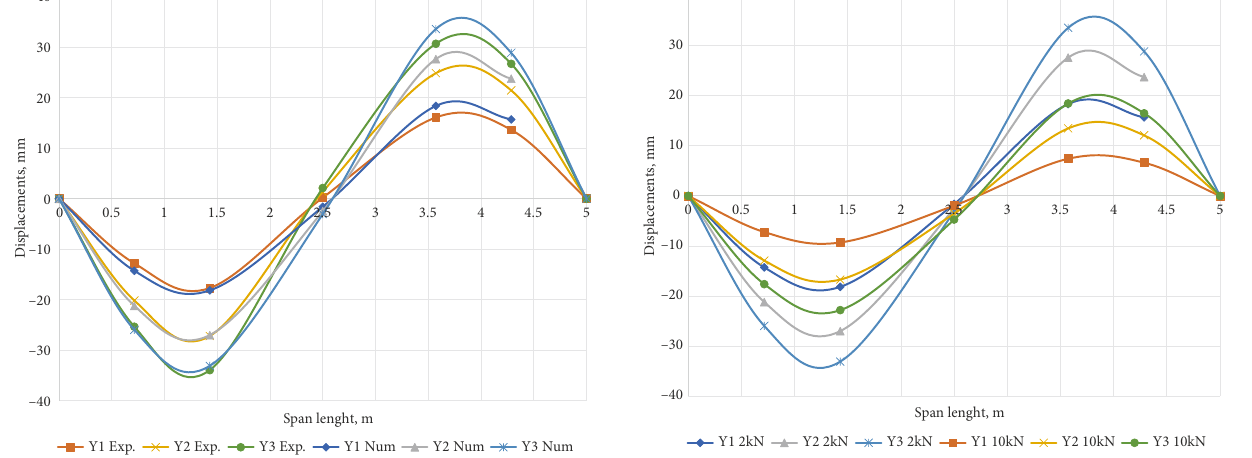
Figure 6. Displacements results of the experimental ant numerical investigation of the combined string structure,